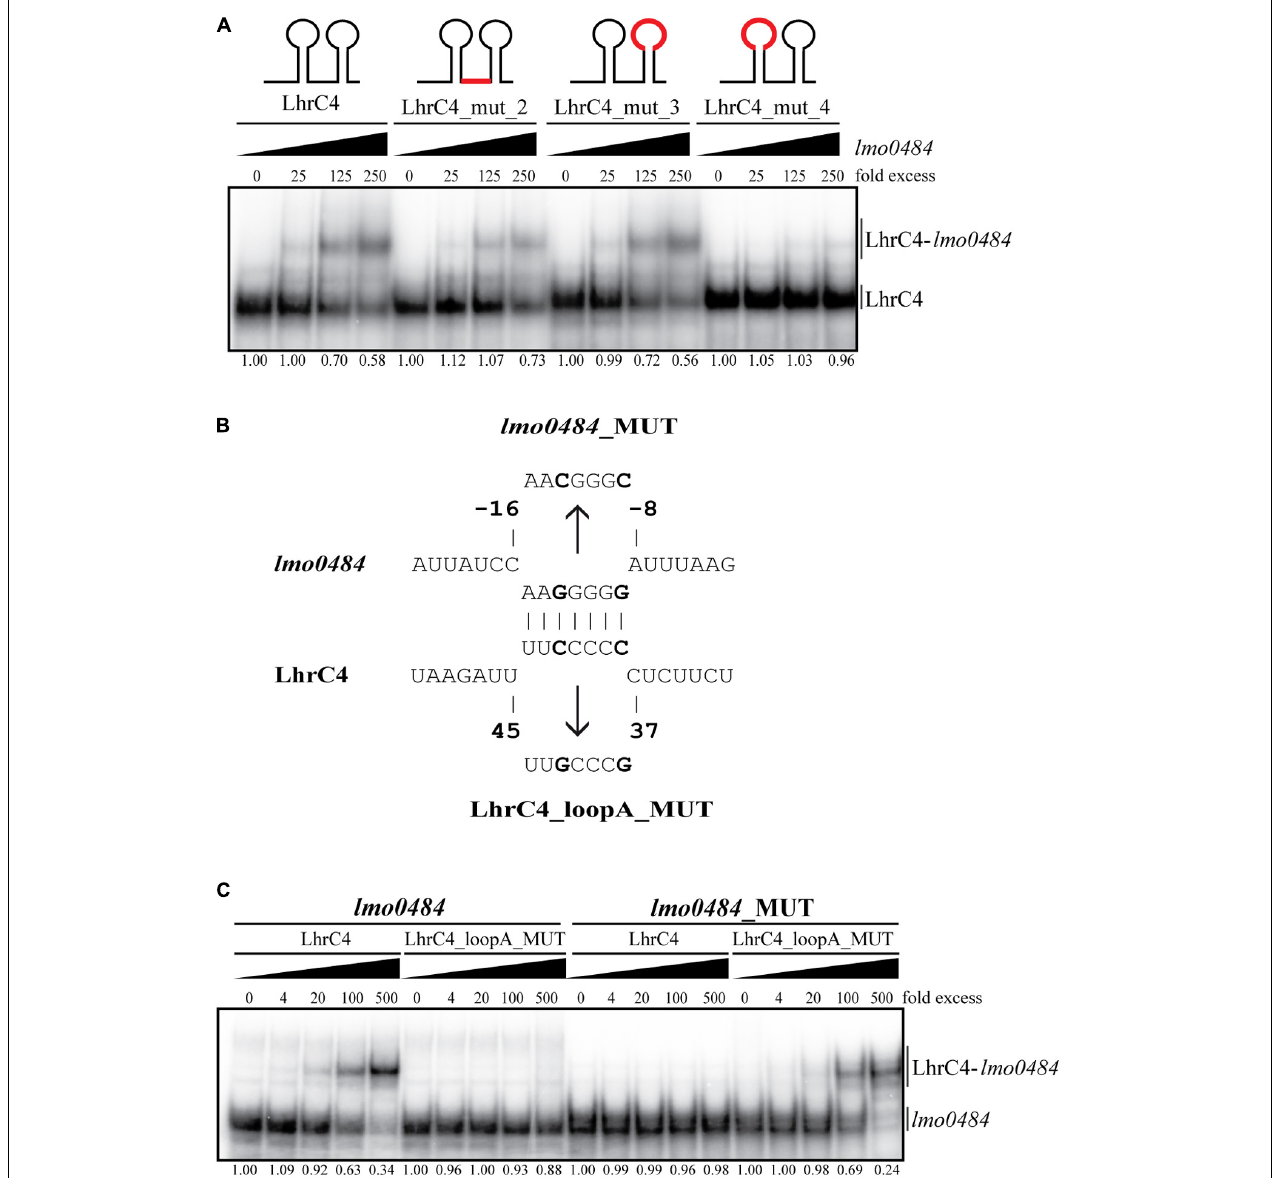
FIGURE 5 | Electrophoretic mobility shift assays (EMSAs) of the interaction between LhrC4 and lmo0484 mRNA. (A) LhrC4 mutant screening of loop A, single-stranded stretch, and the terminator loop. Labeled LhrC4 and the mutant derivatives were tested for their ability to interact with unlabeled lmo0484 RNA. The mutated regions are shown in red in the sRNA sketches. LhrC4: wild-type LhrC4; LhrC4_mut_2: mutation in single-stranded stretch; LhrC4_mut_3: mutation in terminator loop; LhrC4_mut_4: mutation in loop A. The fraction of unbound LhrC4 is shown below each lane. (B) Predicted basepairing between the SD region of lmo0484 mRNA and loop A of LhrC4. The mutated nucleotides are shown in bold and the sequences of the minimal mutant variants lmo0484 _MUT and LhrC4_loopA_MUT are indicated. (C) Labeled lmo0484 RNA and lmo0484 _MUT were each incubated with increasing concentrations of unlabeled LhrC4 or the mutant variant LhrC4_loopA_MUT. The fraction of unbound lmo0484 RNA is shown below each